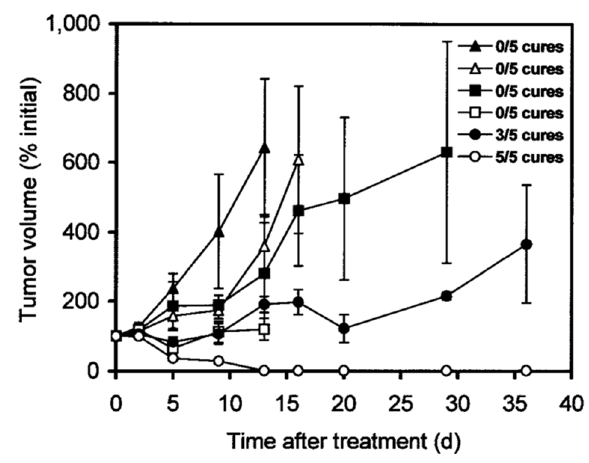
Figure 2. Treatment study comparing pretargeted and directly labeled radioimmunotherapy. Ramos lymphoma xenograft-bearing mice were injected with saline alone ( ▲ ), with control NR-LU-10-sAv followed by CA and later by 29.6 MBq (800 µCi) of 90 Y-DOTA-biotin ( △ ), with 7.4 MBq (200 µCi) ( ■ ) or 14.8 MBq (400 µCi) ( □ ) of directly labeled 90 Y-1F5, or with 1F5-sAv followed by CA and later by 14.8 MBq (400 µCi) ( ● ) or 29.6 MBq (800 µCi) ( ○ ) of 90 Y-DOTA-biotin. Image from Ref.[39].